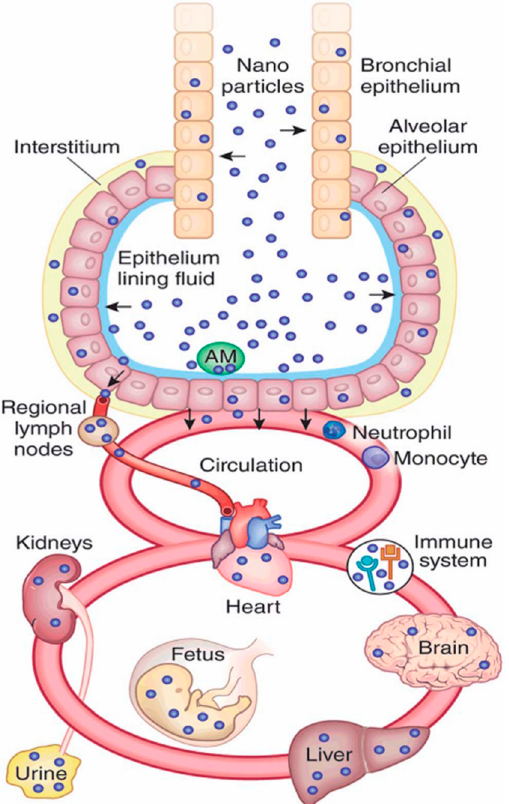
Figure 1. Schematic diagram of nanoparticle pathways through the human body after